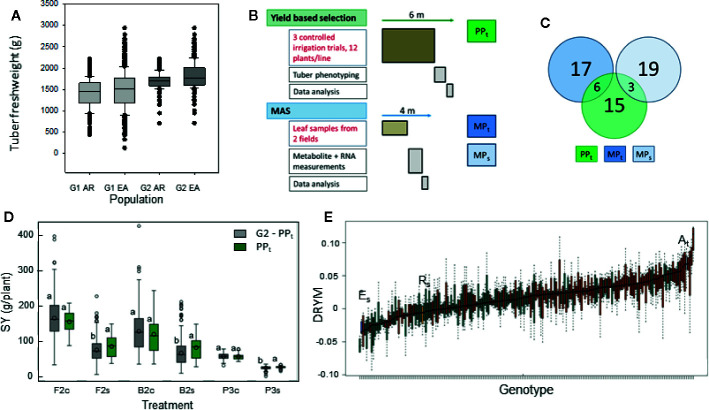
Selection experiment comparing phenotypic selection and MAS from a potato population segregating for drought tolerance. (A) Distribution of tuber dry weight in segregating population G1 before selection for above average yield (~600 lines) and population G2 after selection for yield (~200 lines) (experiment P1, yield from three plants, AR = offspring from cross At×Rs, EA = offspring from cross Es×At) (B) Scheme comparing procedure and timeline for phenotypic, yield-based selection of subpopulation PPt, and MAS of subpopulations MPt selected for superior tolerance and MPs selected for inferior tolerance from 200 G2 lines. Duration of tasked written in red is fixed, duration of those written in black depends on resources. For detailed project plan see
Data Sheet 1
,
Figure S1
. (C) Venn diagram showing the number of lines in each subpopulation and the overlap between the subpopulations. There is no overlap between the marker selected populations MPt and MPs. (D) Tuber starch yield of the phenotypically selected PPt compared to the remaining lines of G2 grown under optimal (c) and reduced (s) water supply in big-bag/pot (B2, P3) and field trials (F2) with significant water stress. Different letters indicate significant differences between population within an experiment and treatment (REGWQ-Test, α = 0.05). (E) Drought tolerance predicted from metabolite concentrations for parent cultivars and G2 lines from the crosses At×Rs (red) and Es×At (green).